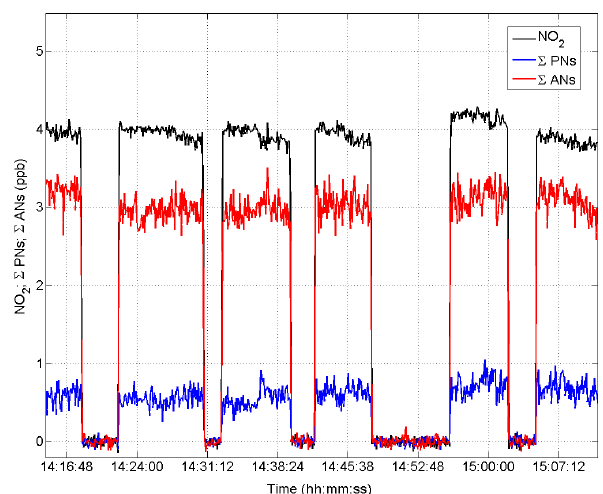
Fig. 5. Measurements of a mixture of NO 2 , PAN and ethyl nitrate with distinct cells of the TD-LIF generated in a laboratory test. Zero air is sent periodically to check the capability of the system to flush the organic